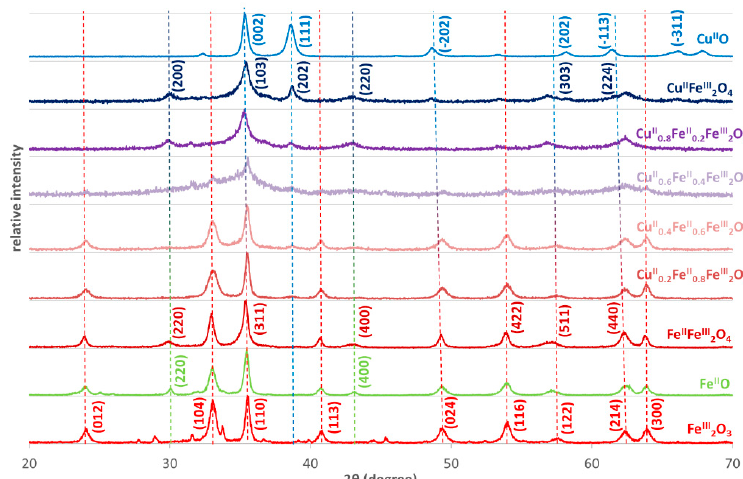
Figure 2. X-ray diffraction (XRD) diffractograms of iron(II) doped copper ferrites compared to those of the simple oxides of the given metal ions. The characteristic Miller indices indicated for the compounds the standards of which were earlier studied by XRD are taken from the International Centre for Diffraction Data.